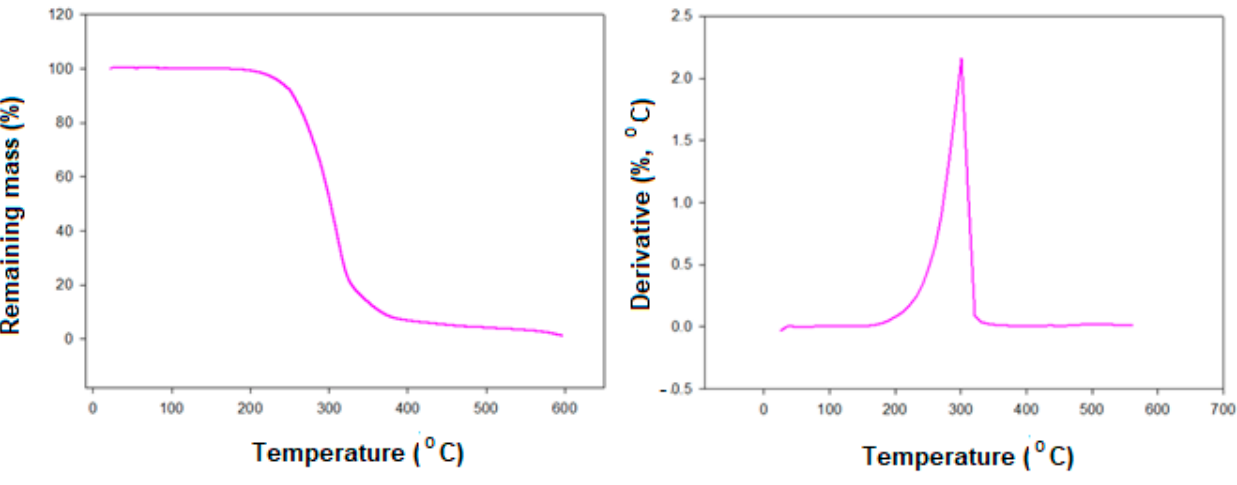
Figure 8. TG ( a ) and DTG ( b ) thermograms of the complex Ia/II .